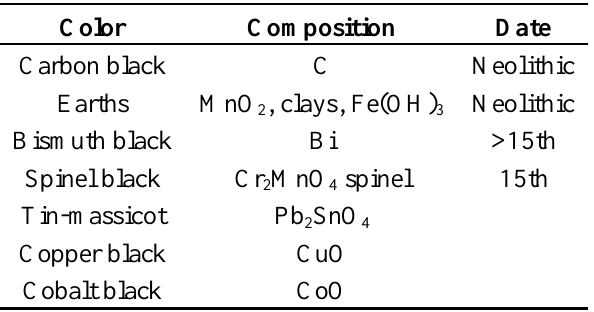
Table 6. Name and composition of black pigments and colouring agents. Dates of innovation (first production) are